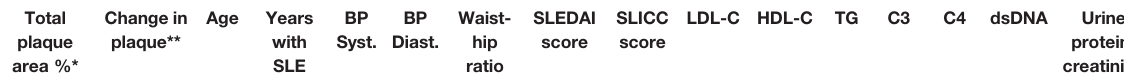
TABLE 5 | Correlations between normalized carotid plaque area and markers of dyslipidemia and of SLE disease activity and